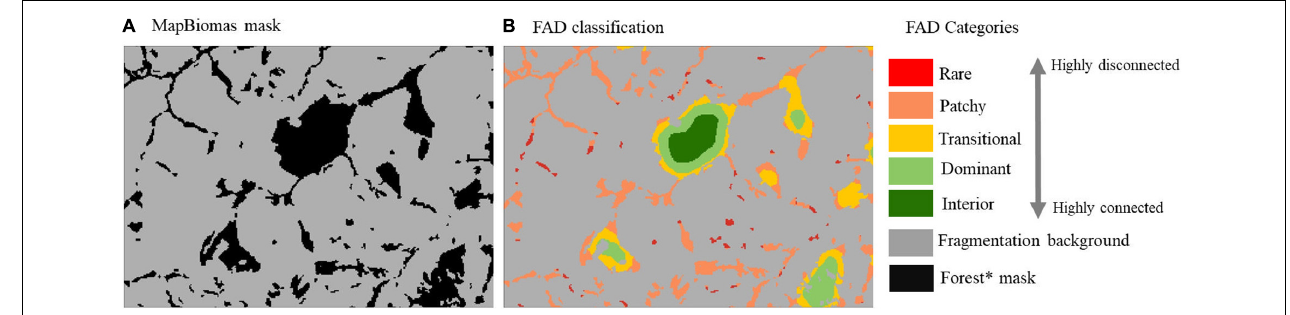
FIGURE 1 | Example of Forest Area Density (FAD) classification categories applied to a MapBiomas mask. (A) MapBiomas mask for input on GUIDOS toolbox. (B) FAD classification output. Forest ∗ mask for Amazonia include only MapBiomas Forest category; for Cerrado it includes Forest, Savannas, and Natural Grasslands. Fragmentation background are all the MapBiomas remaining LC categories (e.g., Cropland, pasture, urban, water,